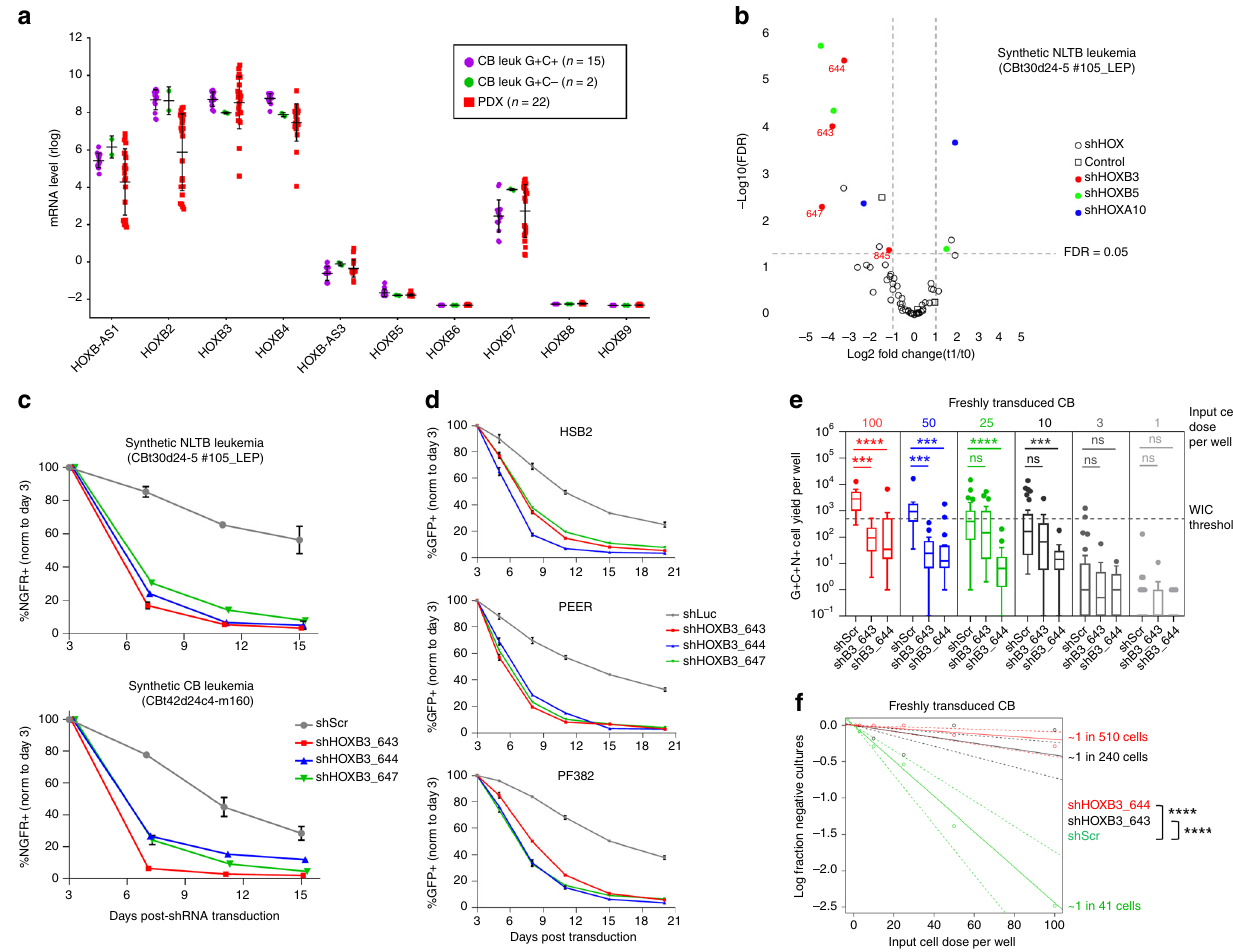
Fig. 8 HOXB genes confer growth advantage in human T-ALL initiation and maintenance. a HOXB mRNA expression level in 17 CB leukemias and 22 PDX samples. Rlog values were calculated from RNA-seq data using DESeq2 and corrected for batch effects using ComBat. Each datapoint represents an individual sample with mean ± SD indicated. b Volcano plot of HOX shRNA depletion/enrichment. Primary CB leukemia cells were transduced with a 59-